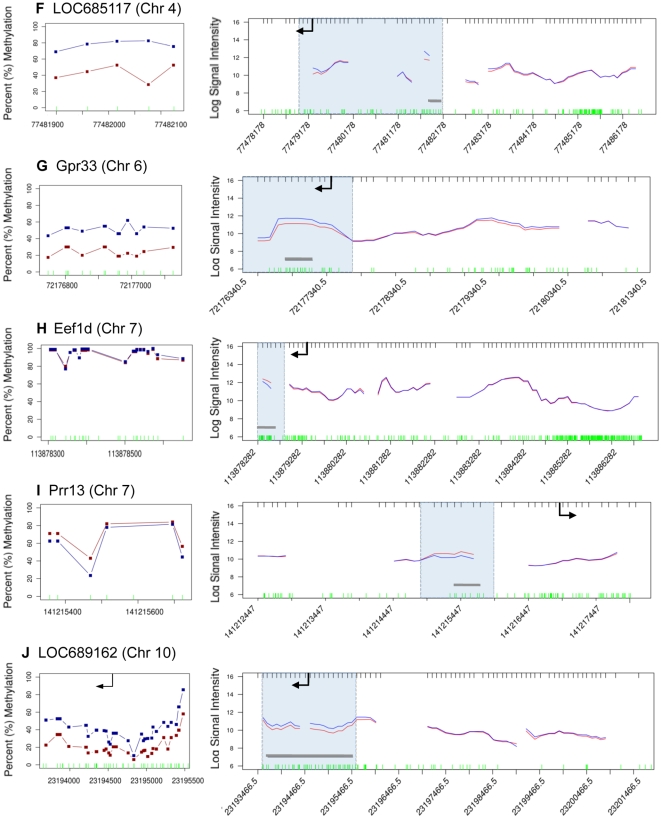
Refer to 
Figure 2
 Legend.